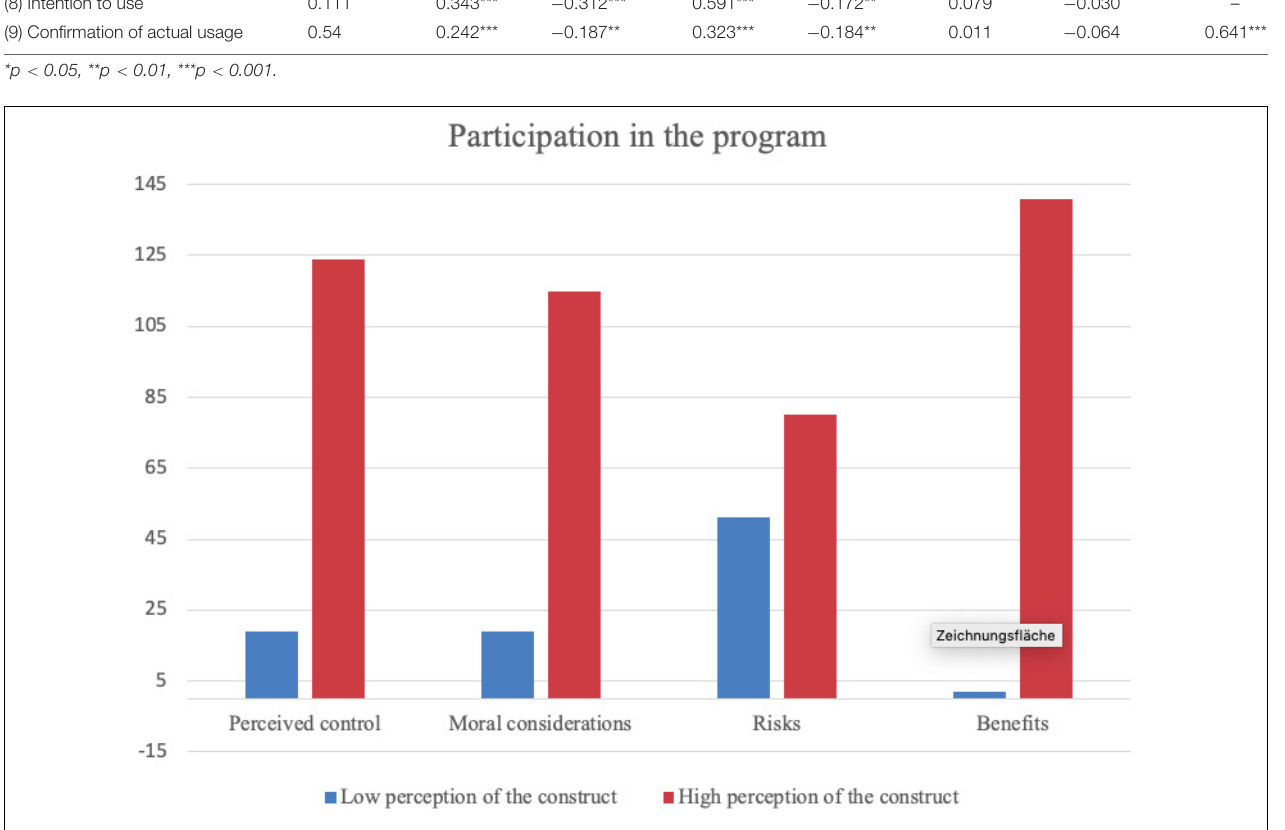
FIGURE 3 | Overview of program participation in dependence of significant